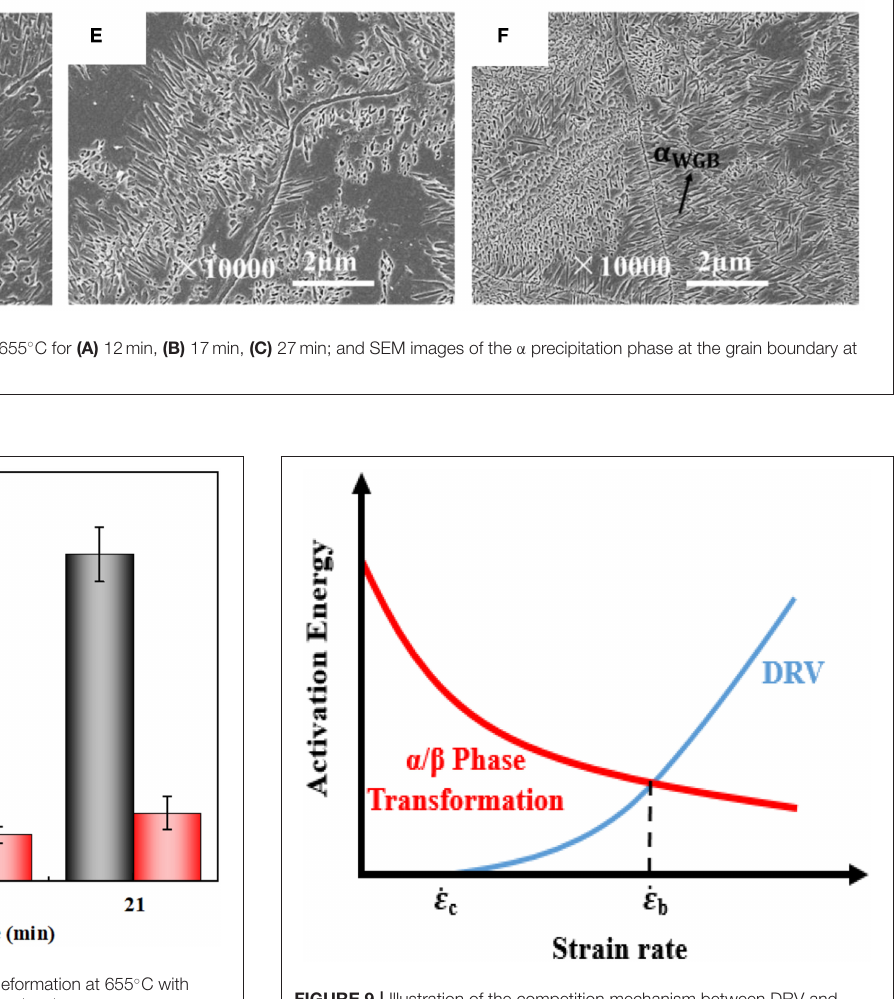
FIGURE 9 | Illustration of the competition mechanism between DRV and phase transformation with the variety of strain rate during the thermo-mechanical